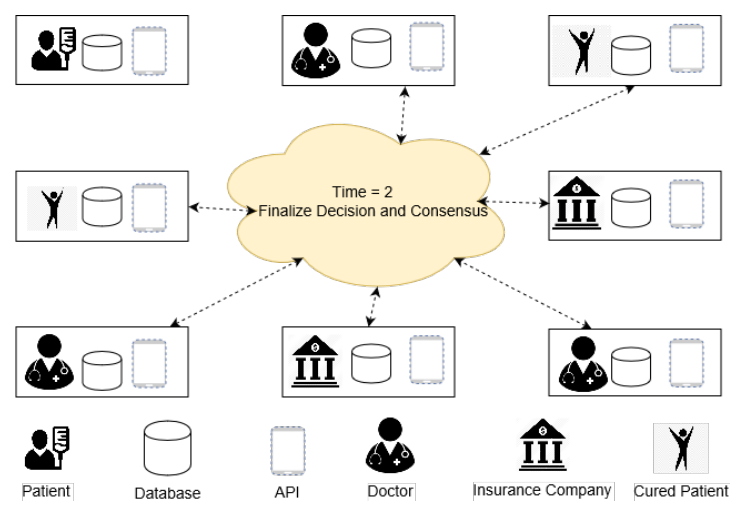
Figure 10. At time 2: Finalize the individual decision and consensus gathering from entities.